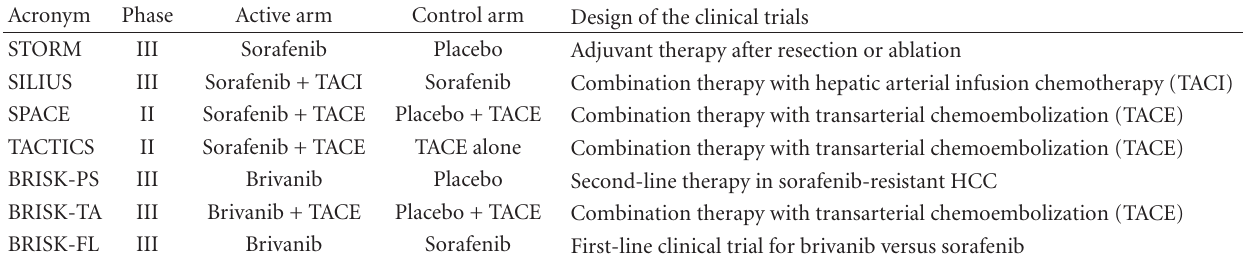
Table 2: Ongoing clinical trials using molecular-targeted agents for hepatocellular carcinoma.